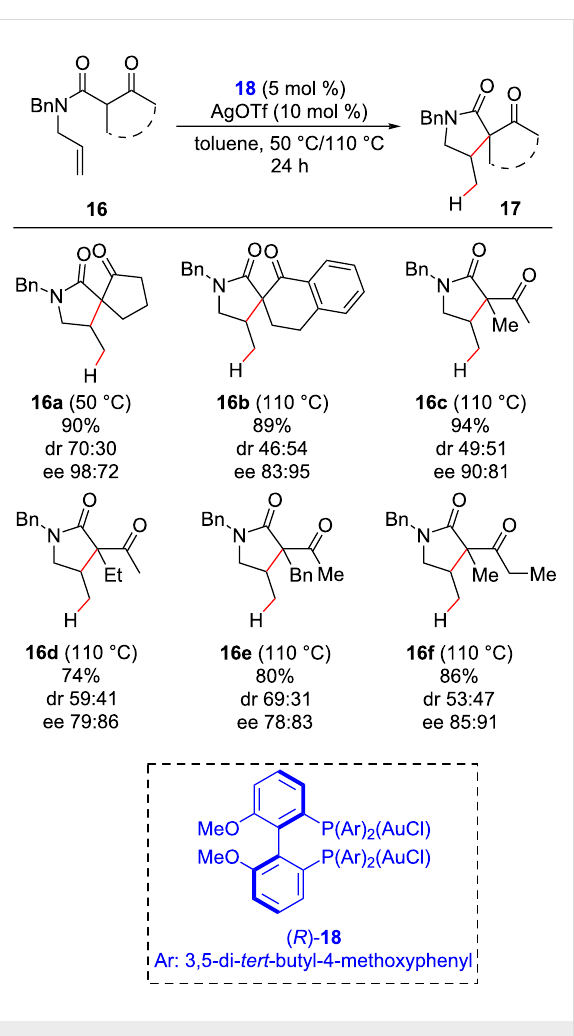
Scheme 9: Asymmetric pyrrolidine synthesis through intramolecular hydroalkylation of α -substituted N -alkenyl β -ketoamides by chiral gold catalysis (Gandon (2014) [42]).